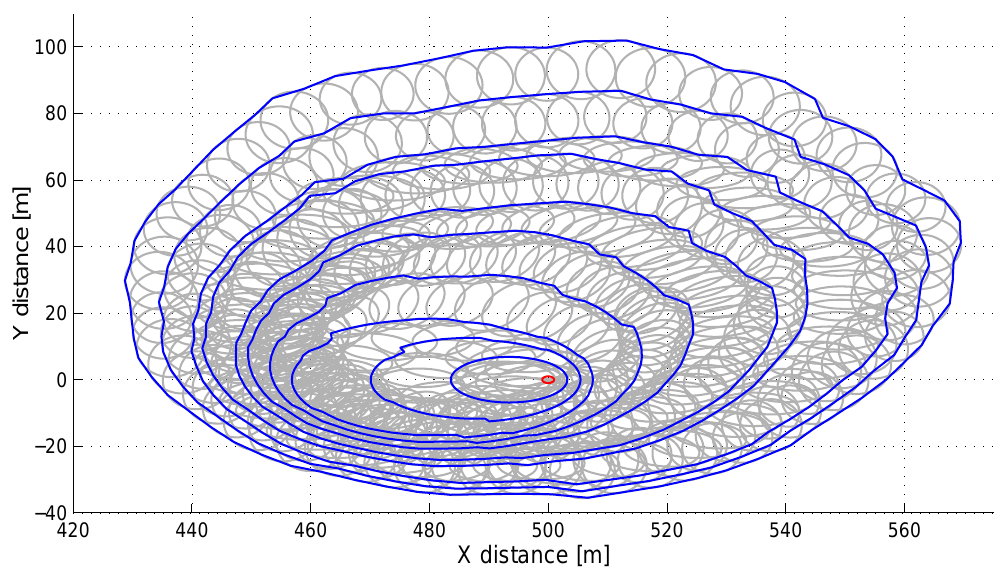
Figure 1. Example of Huygens expansion with elliptical firelets (grey lines) from an ignition point (red dot in the centre). Ten fire fronts (blue lines) are plotted during the spread of the fire over an heterogeneous fuel depth (0.6 ± 0.3m) and under changing wind (5 ± 2ms − 1 ) speed and direction at every time step (1min each). This Rothermel–Huygens model is also used in FARSITE (Finney, 1998).